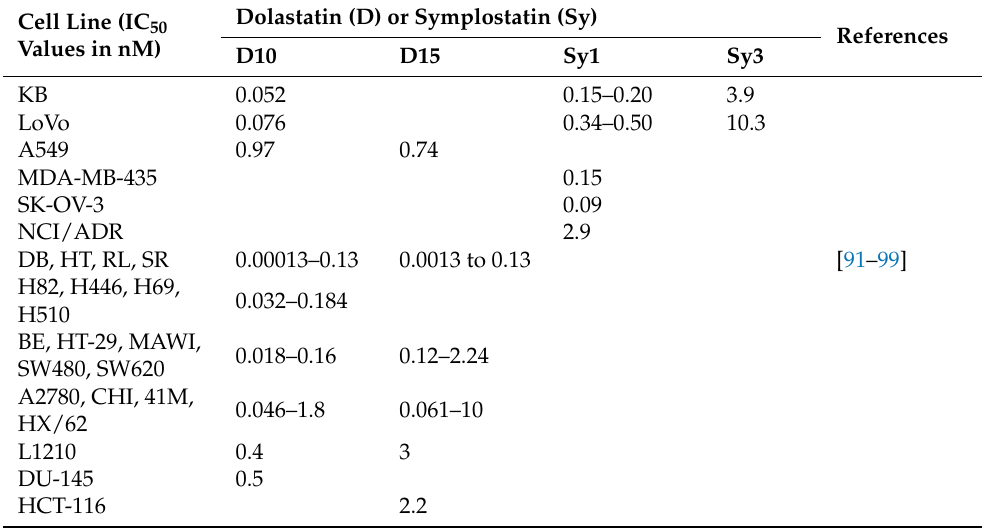
Table 8. Dolastatins and symplostatins activities on the cancer cell